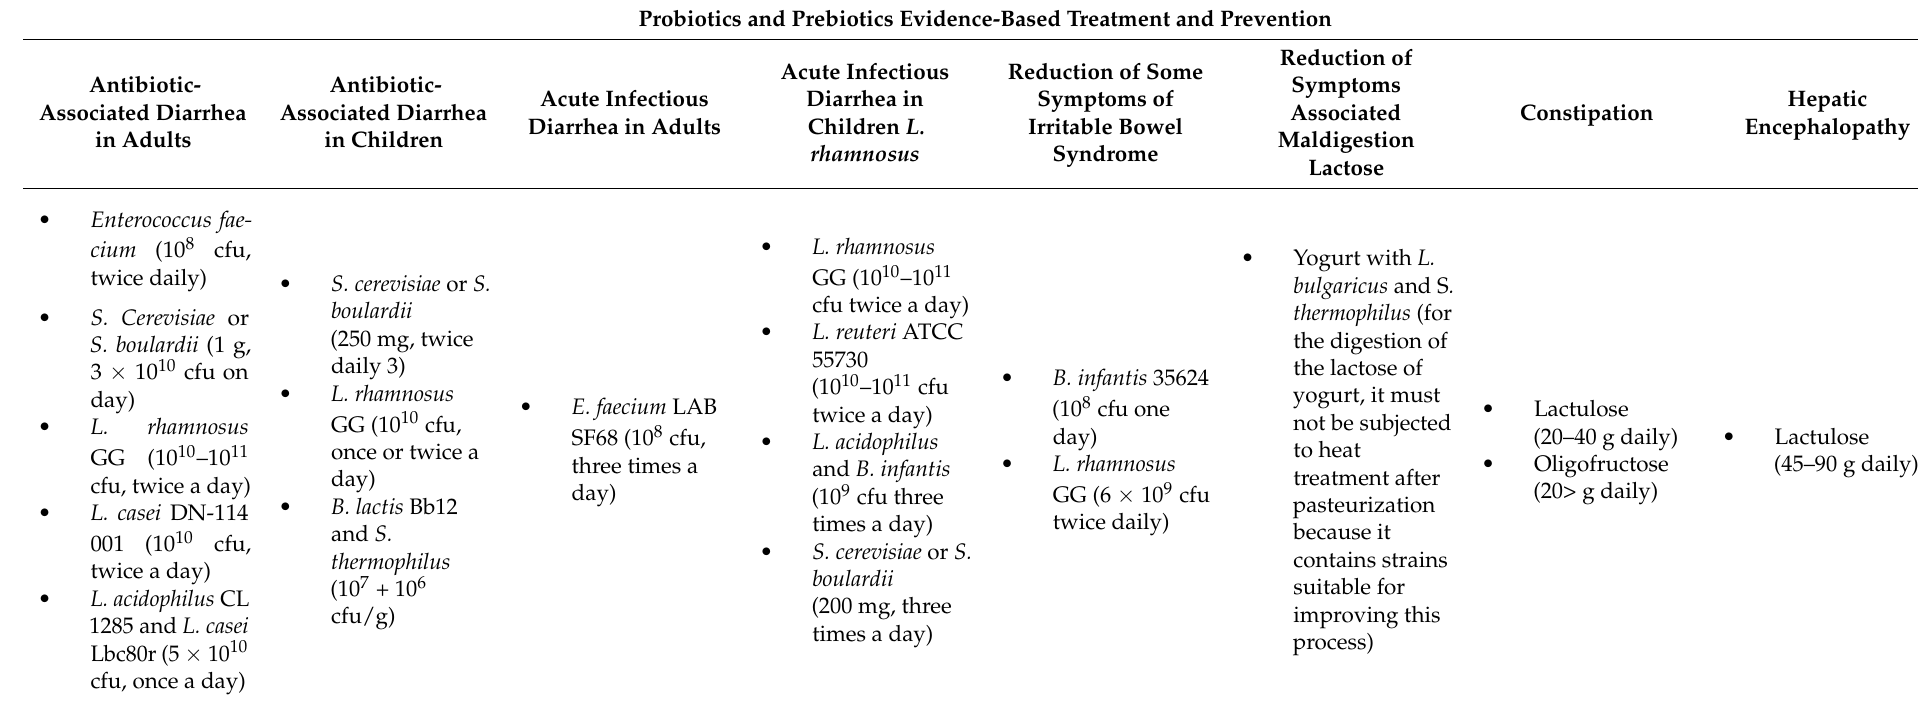
Table 2. The table presents some evidence-based treatment and prevention indications for the use of probiotics and prebiotics for certain gastrointestinal disorders